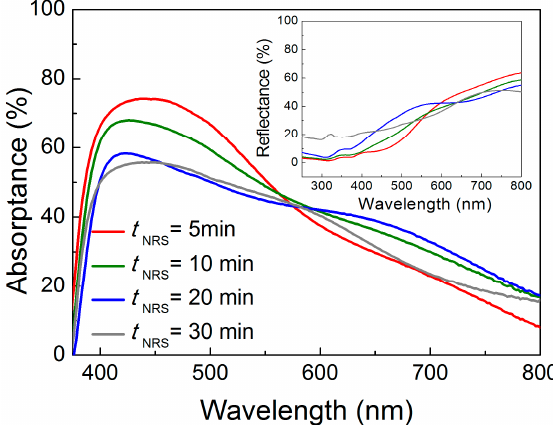
Figure 7. UV-Vis-NIR (ultra violet - visible - near infrared) absorption spectra of the ZnO nanorod substrates produced at 70 °C with different synthesis times (5, 10, 20 and 30 min), after silver nanoparticle deposition with 6 nm Ag mass equivalent thickness.